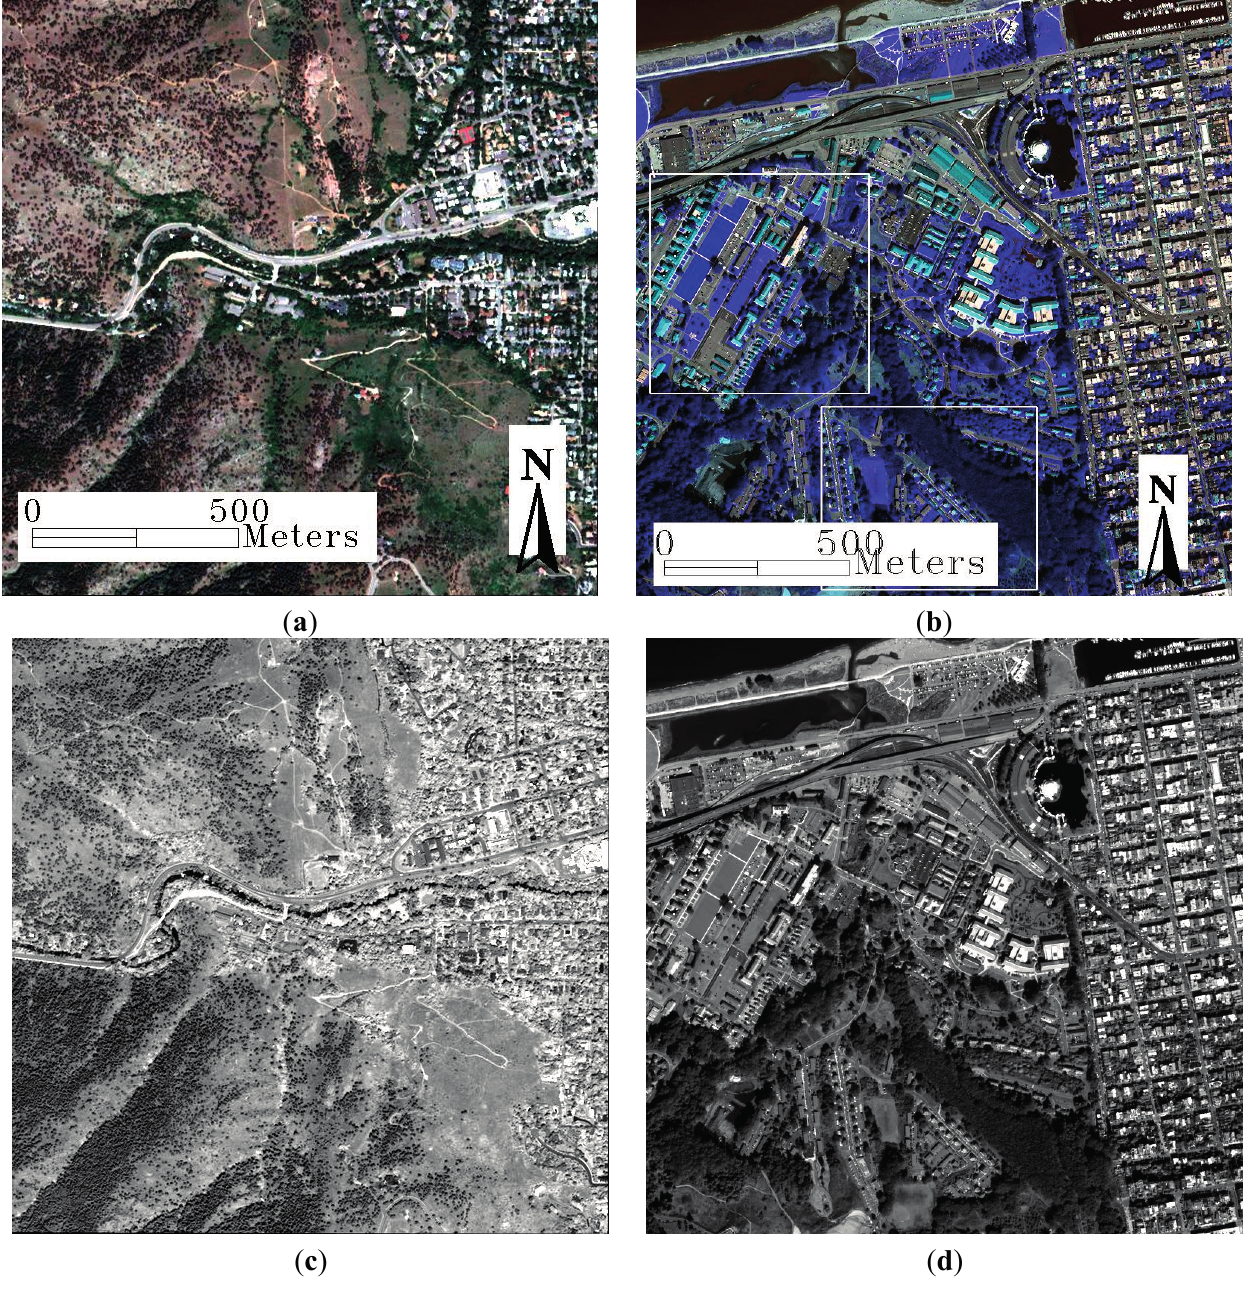
Figure 1. Color compositions of ( a ) the original QuickBird MS image (2.4 m) at 600 × 600 pixels combined from red, green and blue bands and ( b ) the original WorldView-2 MS image (2.0 m) at 800 × 800 pixels combined from green, red and red edge bands. The degraded Pan images for ( c ) QuickBird at 2.4 m and ( d ) WorldView-2 at 2.0